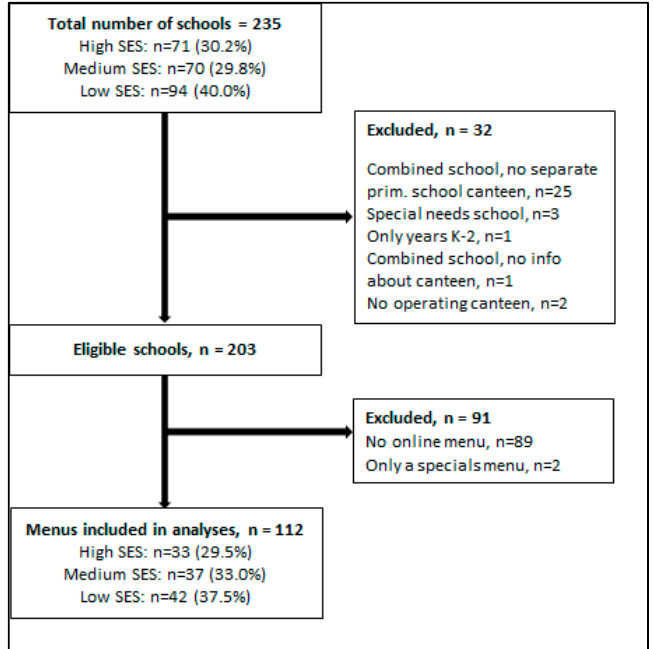
Figure 1. Flowchart of screening process of schools.